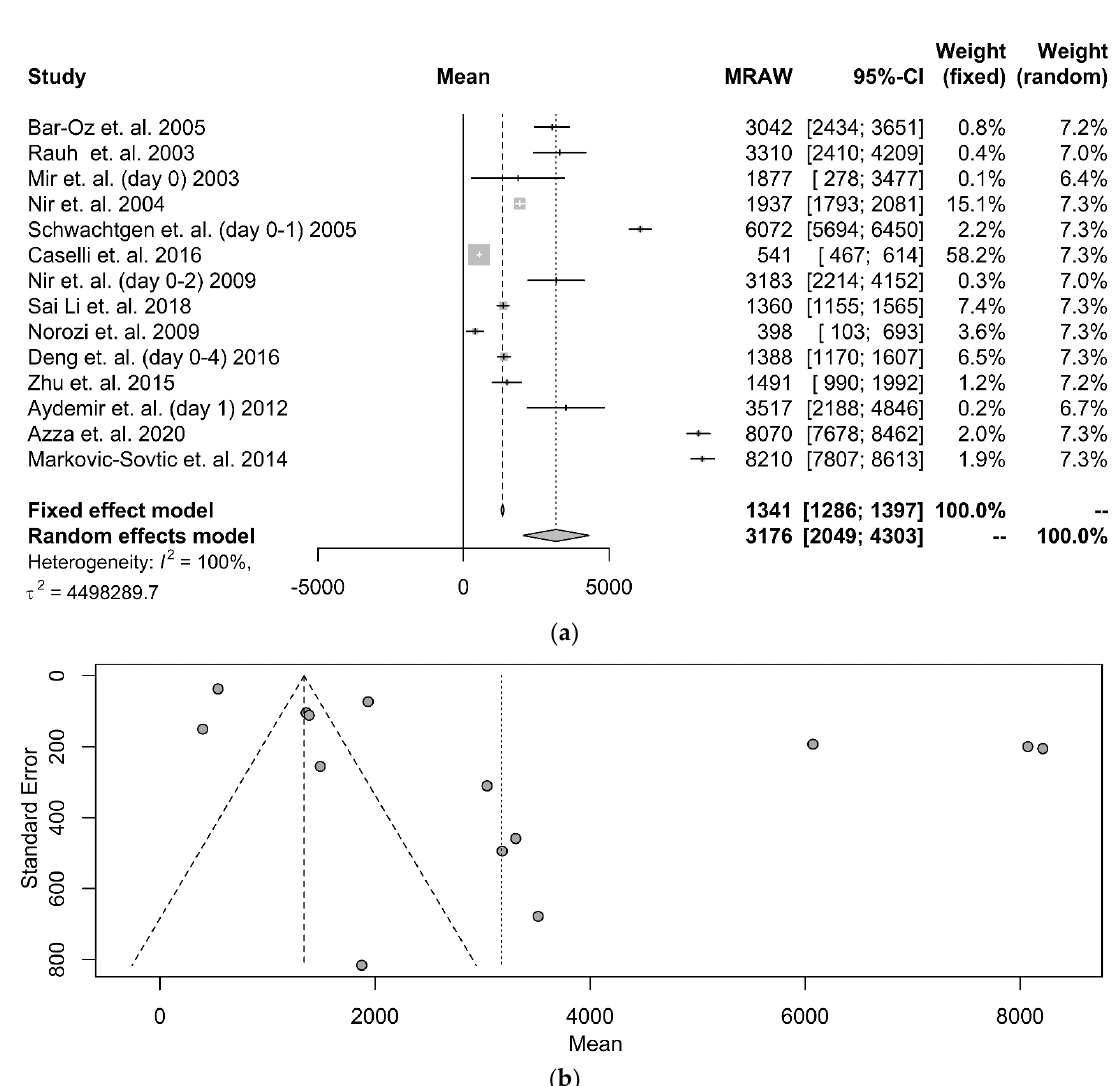
Figure 3. ( a ) A forest plot that presents the meta-analysis of the NT-proBNP values of healthy term neonates during the neonatal period, after the application of the random or the fixed model. The first column refers to the first author, the year of publication, and the day of neonates’ life on which the measurement occurred (in parentheses). The second column represents the mean value and the standard deviation graph. The next 3 columns show the mean value and the 95% confidence